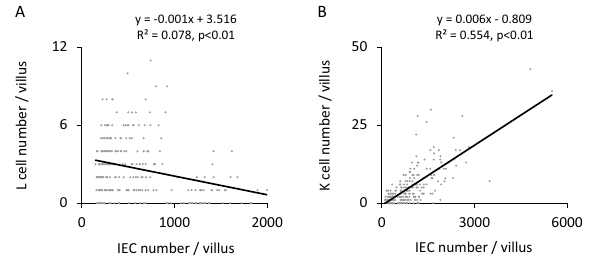
Figure 7. Association between intestinal epithelial cell (IEC) number and incretin-producing cell number in villus. A single regression analysis between IEC number per villus and ( A ) L cell number per villus and ( B ) K cell number per villus (n = 50 villi in 5